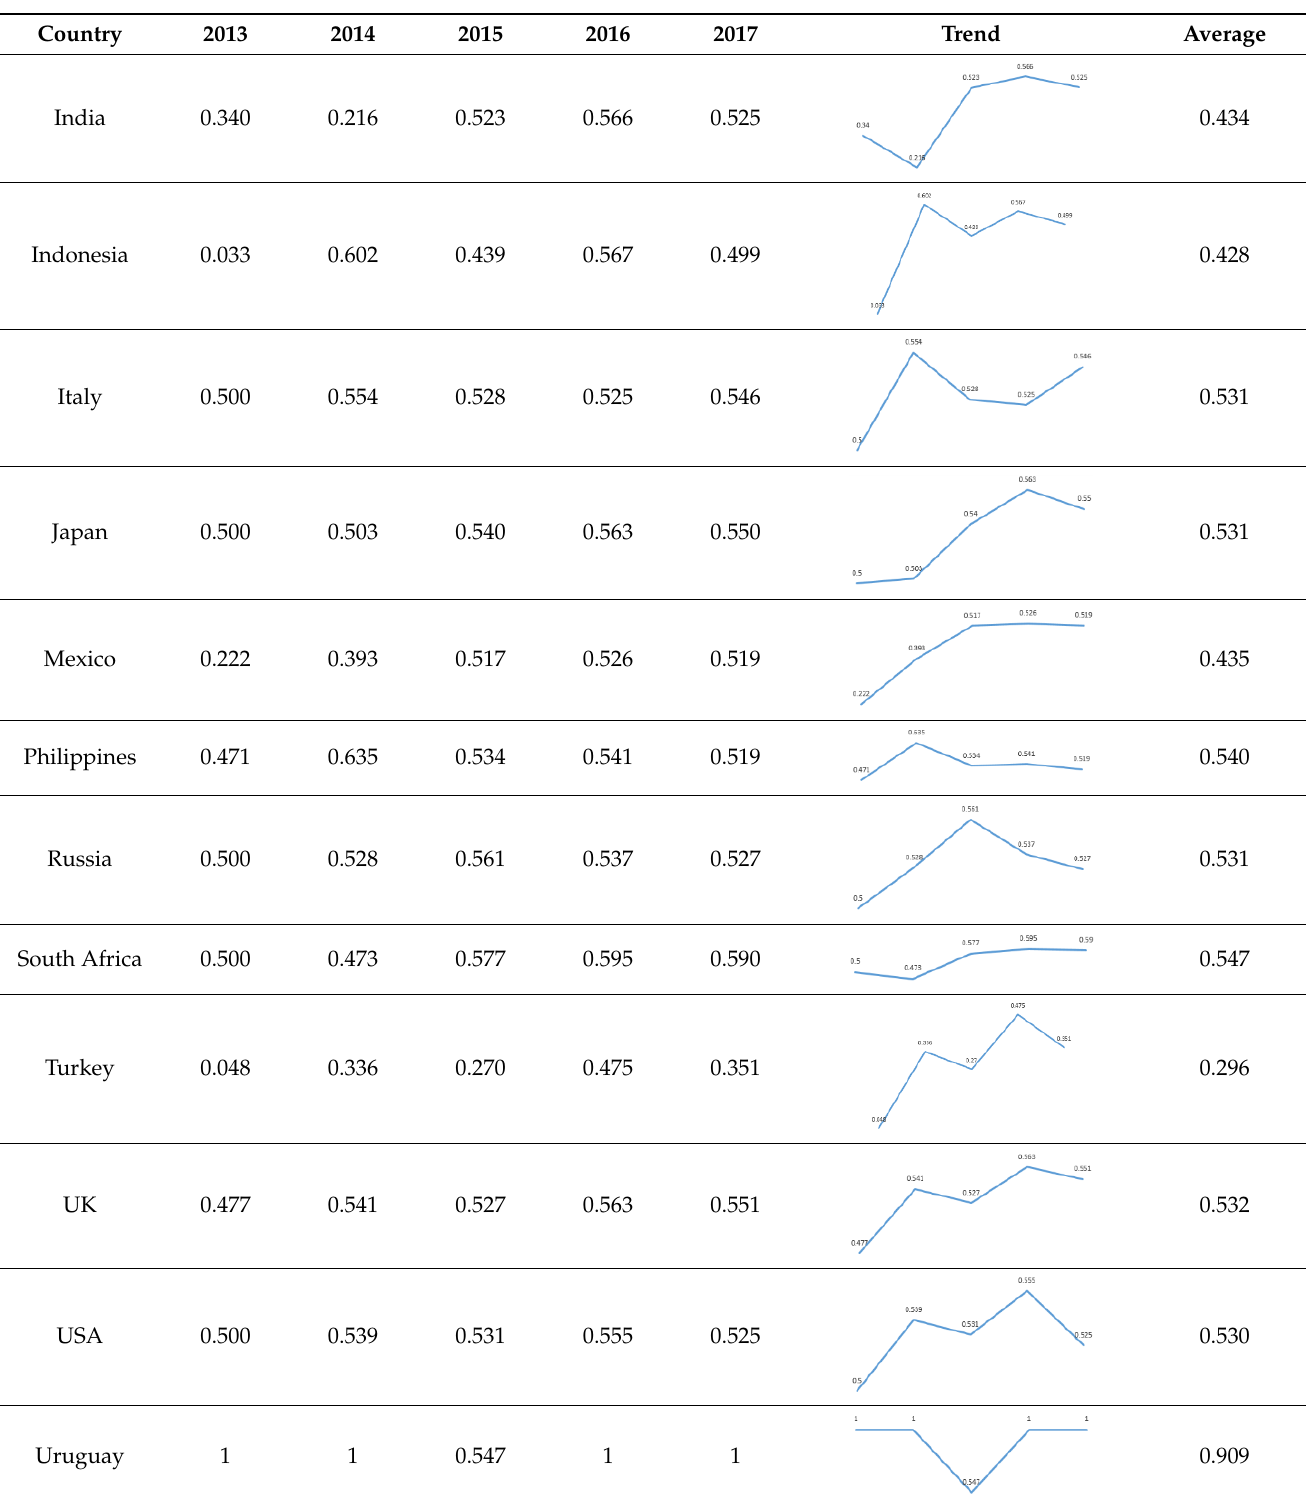
11 of 21 Table 6. Evaluation results of anti-corruption efficiency for each year. Country